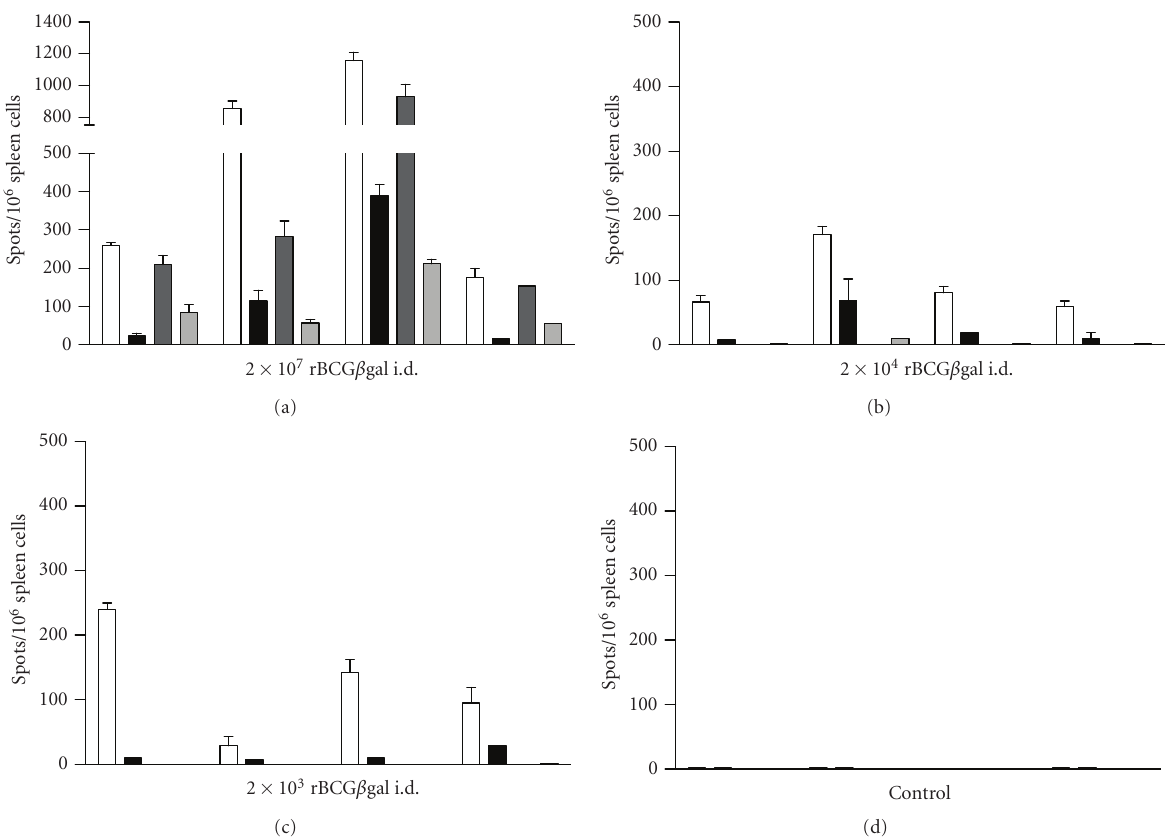
Figure 2: Immune response of four individual mice per group after i.d. immunization with di ff erent doses of recombinant BCG β gal. Mice were immunized as indicated under each graph, with an unimmunized control shown. After 9 weeks, the mice were killed and the number of β -gal- and BCG-specific IFN γ - and IL-4-producing cells in their spleens was determined by ELISPOT assay. Open bars—IFN γ response to BCG; Black bars—IFN γ response to β -gal; Dark gray bars—IL-4 response to BCG; Light gray bars—IL-4 response to β -gal. All values were corrected for background by subtracting the number of spots observed in wells without antigen. Results are representative of two independent